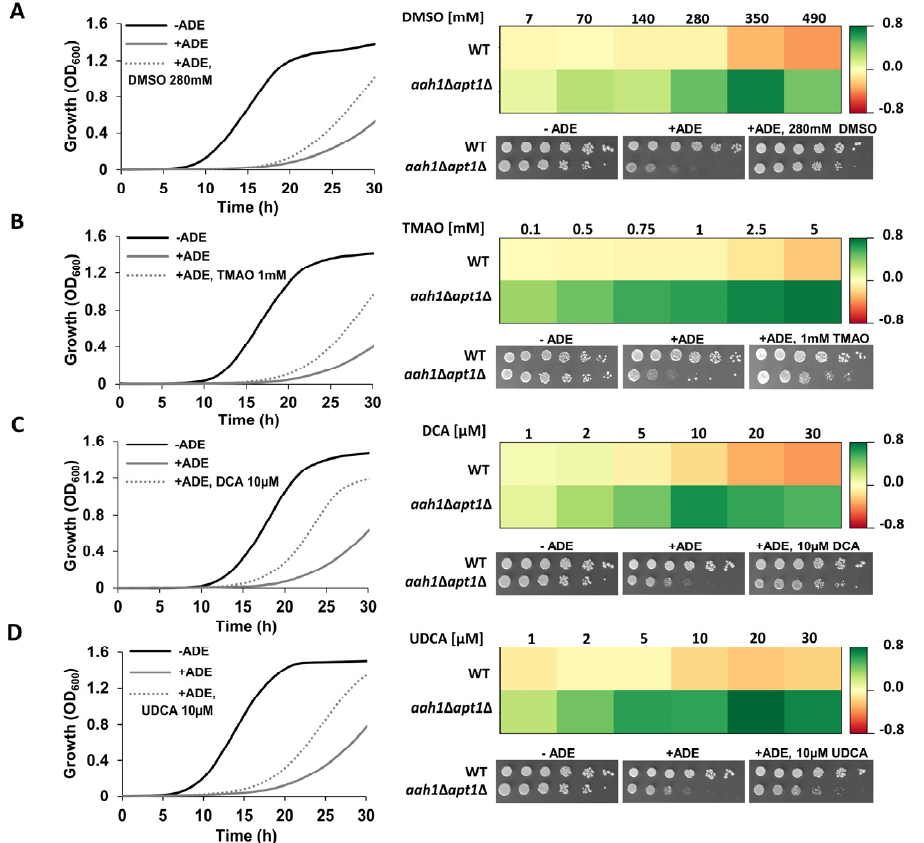
Figure 2. Inhibition of adenine toxicity by chemical chaperones in a yeast model. Left panel: Growth curves of aah1 Δ apt1 Δ cells under the indicated conditions, at selected chaperones concentrations (see Supplementary Figure S1 for full data). Cells were grown at 30 °C and the absorbance at OD 600 was measured over time (see Material and Methods). The results are representative of three independent biological repeats. Right panel: Dose-response heat maps representing the difference in optical density between a chaperone-supplemented culture and the control condition (+ADE) when the control cells reached OD 600 = 0.6. The dose-response heat maps were generated based on the data presented in Supplementary Figure S1. Green, rescue. Red, toxicity. WT and aah1 Δ apt1 Δ yeast were serially diluted and spotted on synthetic defined (SD) media lacking adenine ( − ADE), SD media with adenine supplemented at 2 mg/L as a control for DMSO and TMAO, or with 2 mg/L adenine and 0.1% DMSO as a control for DCA and UDCA (+ADE), and SD with 2 mg/L adenine and the indicated concentration of the chemical chaperone. ( A ) DMSO; ( B ) TMAO; ( C ) DCA; ( D ) UDCA.